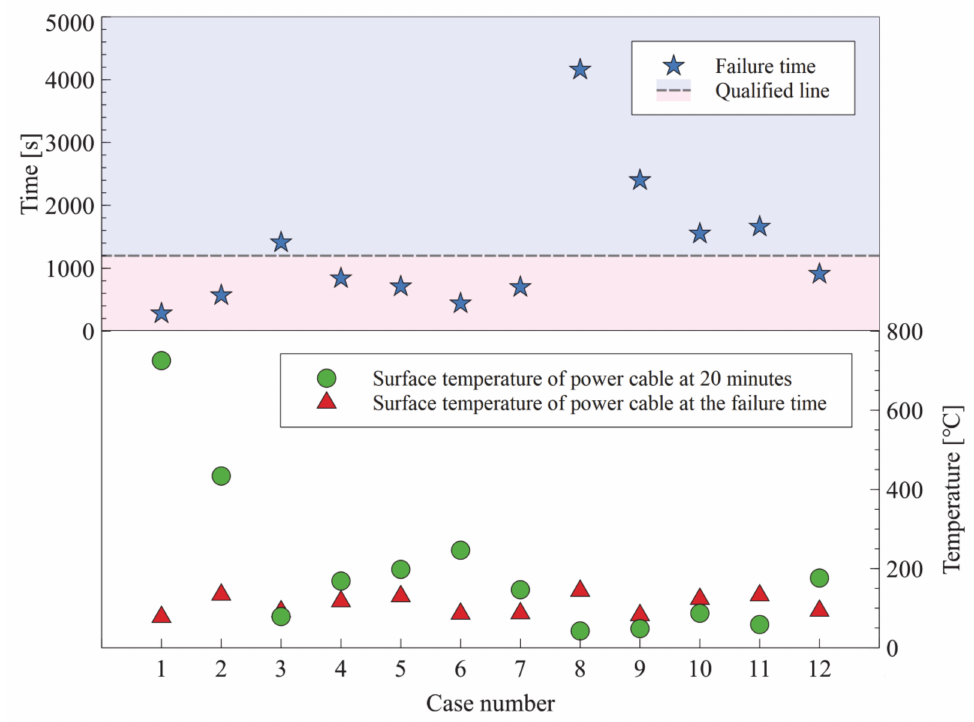
Figure 8. Dot plot of surface temperature of power cable and failure time for 12